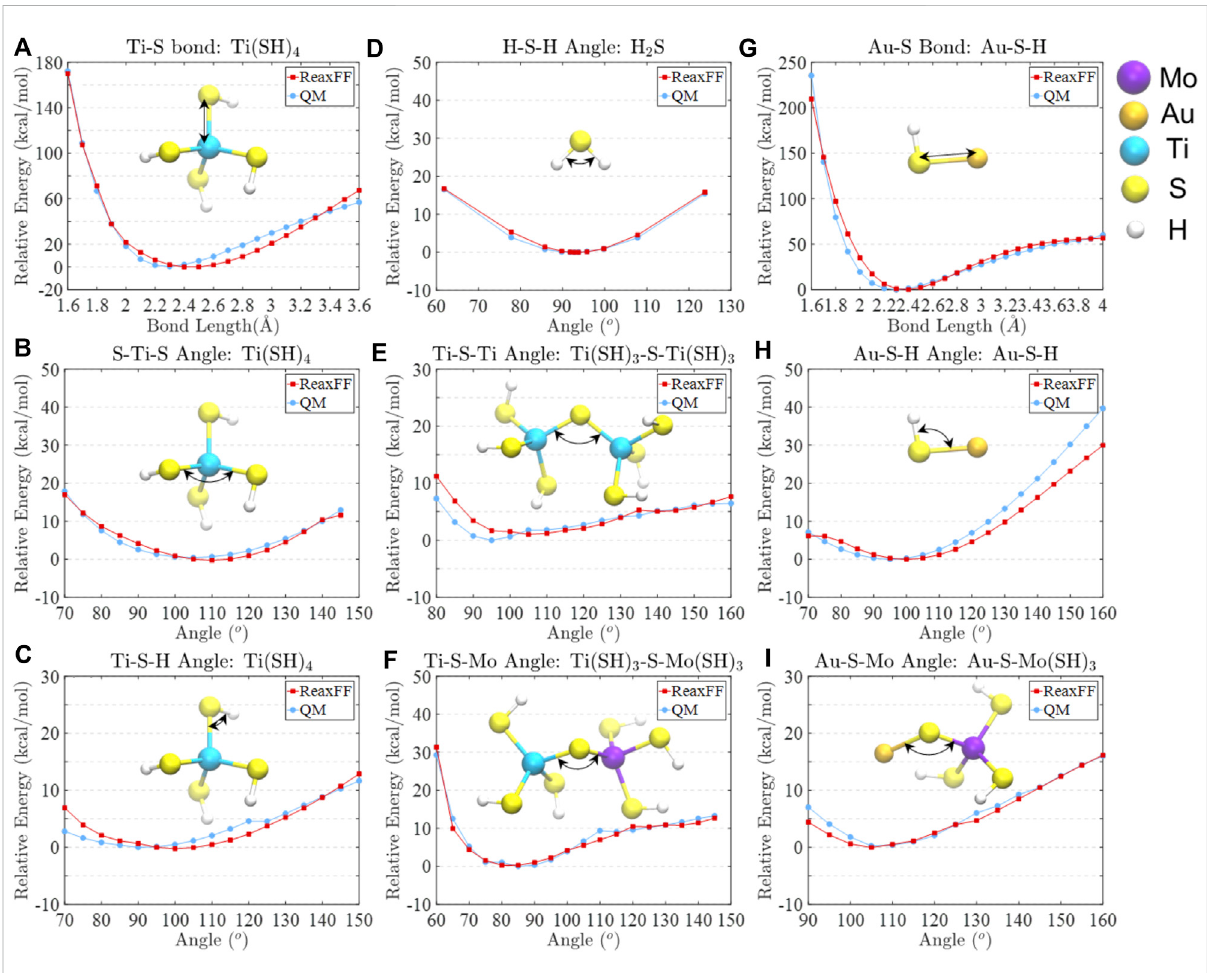
FIGURE 1 Comparisons of relative bond and angle energies between ReaxFF and QM computed data for (A) Ti-S bond in Ti(SH) 4 , (B) S-Ti-S angle in Ti(SH) 4 , (C) Ti-S-H angle in Ti(SH) 4 , (D) H-S-H angle in H 2 S, (E) Ti-S-Ti angle in Ti(SH) 3 -S-Ti(SH) 3 , (F) Ti-S-Mo angle in Ti(SH) 3 -S-Mo(SH) 3 , (G) Au-S bond in Au-S-H, (H) Au-S-H angle in Au-S-H, and (I) Au-S-Mo angle in Au-S-Mo(SH) 3